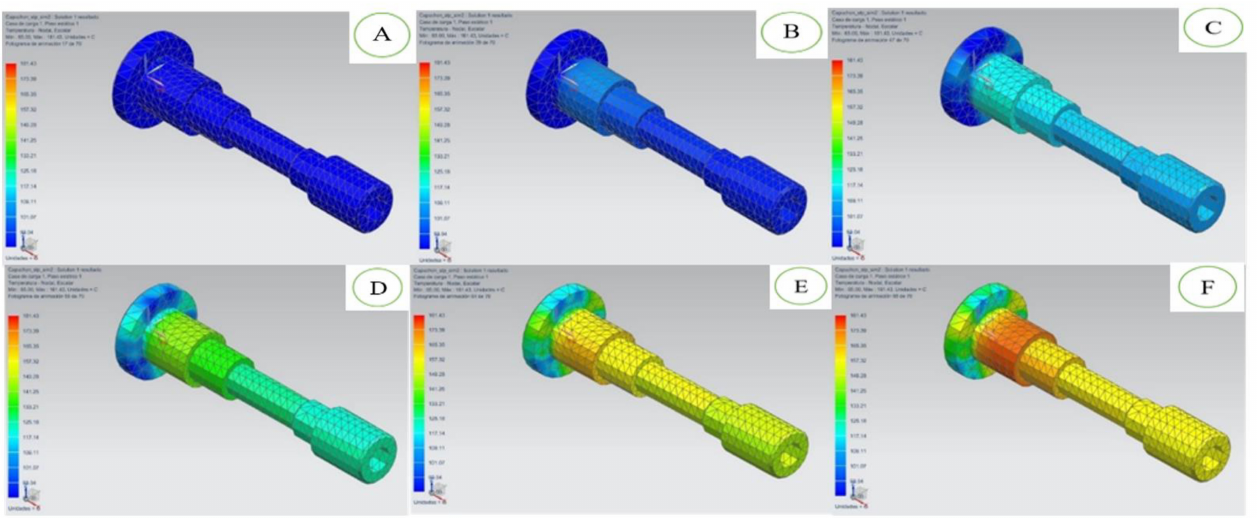
Figure 9. Nylon thermal sequence from ( A – F ) related to the time of